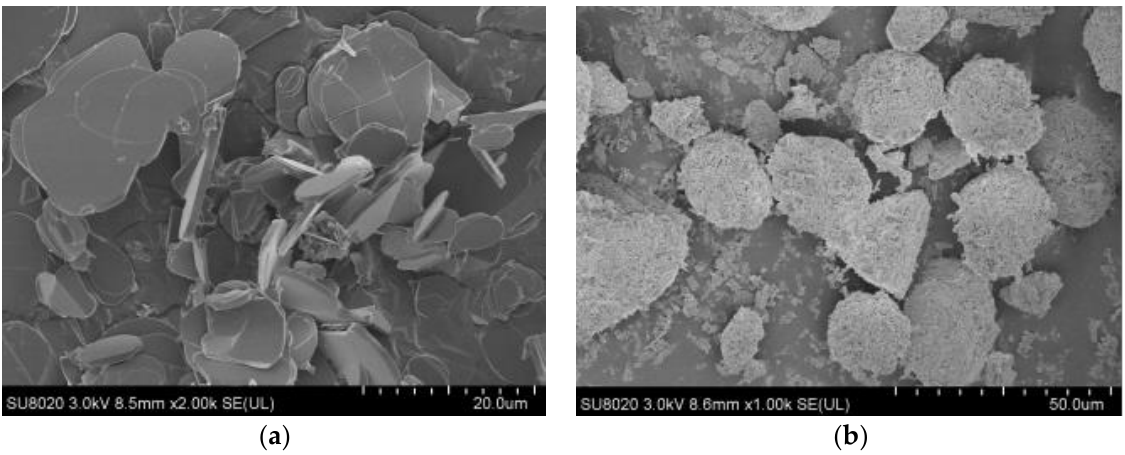
Figure 1. SEM pictures of BN and MgO powders. ( a ) SEM picture of BN; ( b ) SEM picture of MgO.